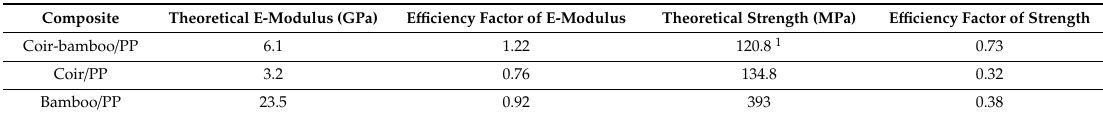
Table 3. Theoretical E-modulus and strength of the hybrid composite estimated by the rule of mixtures, and the e ffi ciency factors of E-modulus and